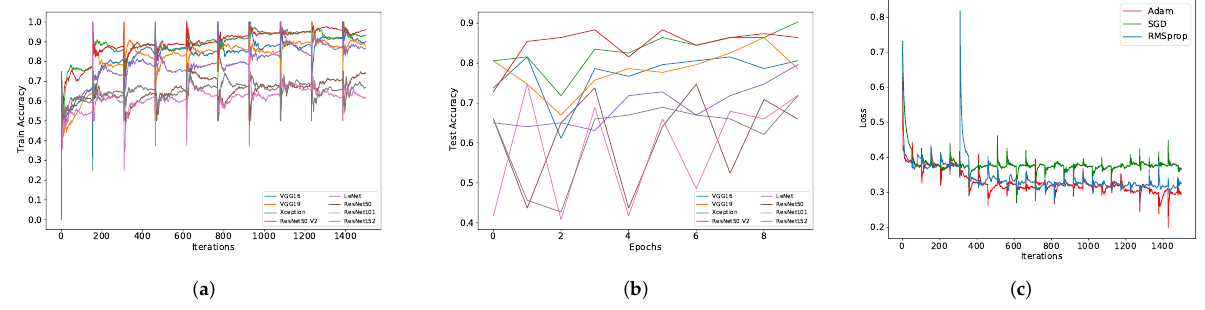
Figure 7. Performance of CNN models during training and validation. ( a ) Training accuracy during iterations. ( b ) Validation accuracy during epochs. ( c ) Comparison of optimizer loss during iterations.